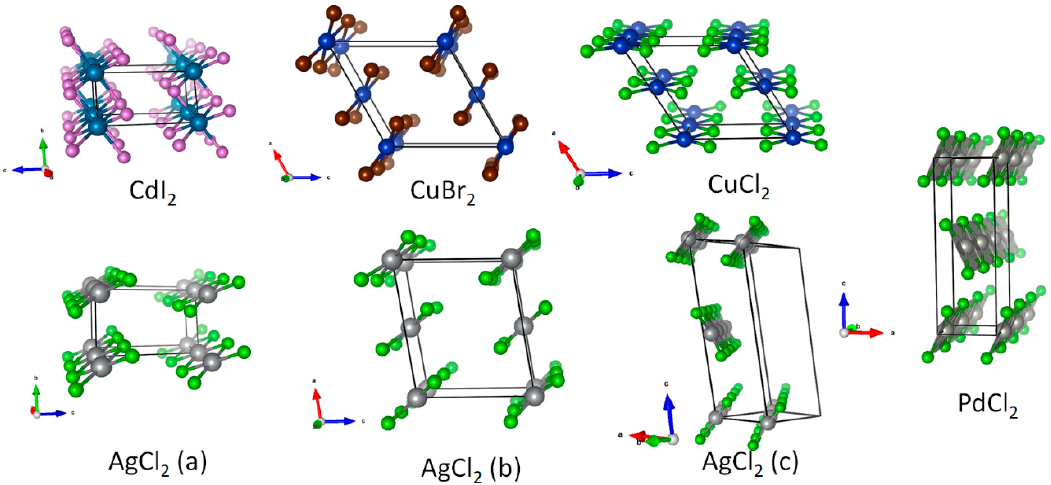
Figure 6. Three hypothetical AgCl 2 ribbon-like polytypes (bottom) obtained with evolutionary algorithms and their relation to the CdI 2 prototype (top left) and the known metal halides with ribbon structure (top and right). The differences of computed energy for ( a – c ) are minuscule.